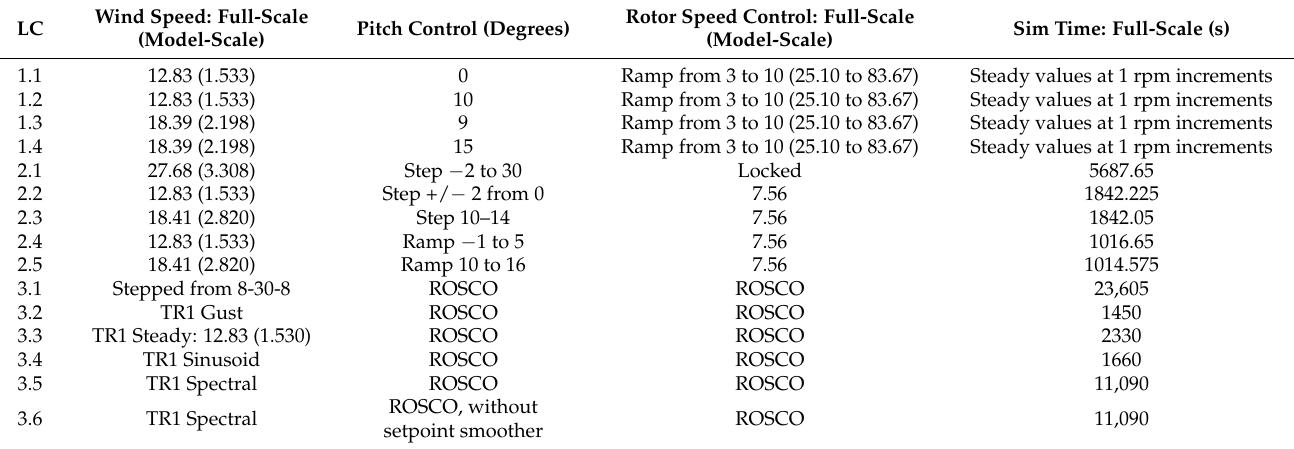
Table 4. Load case definitions and